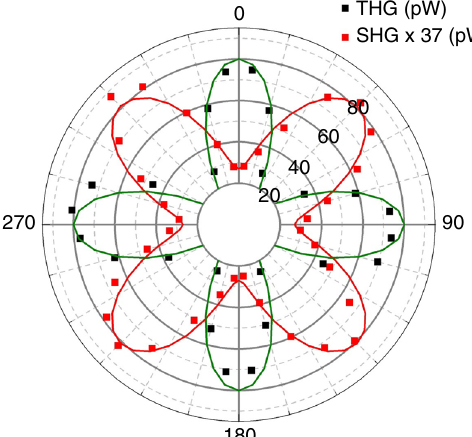
Fig. 5 SHG and THG dependence on the pump light polarization. The polar plot angle corresponds to linearly polarized light when θ = 0° + m · 90°, and to circularly polarized pump light when θ = 45° + m · 90°. The SHG power is multiplied by a factor of 37 to fi t in the same scale as